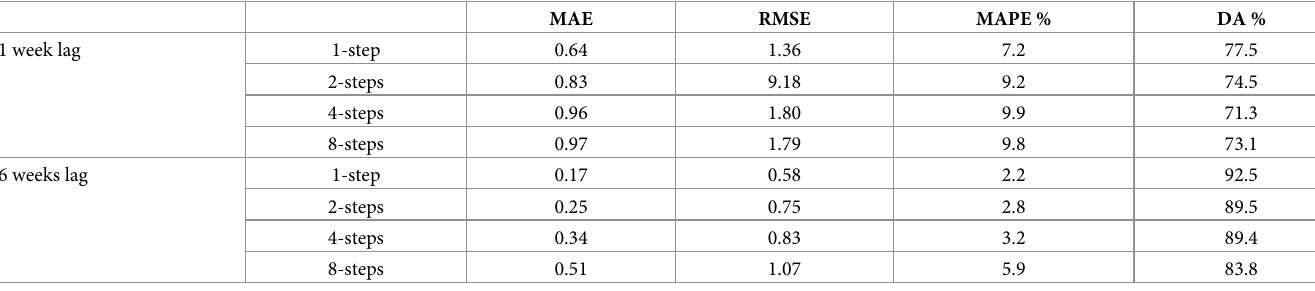
MAE RMSE MAPE % DA